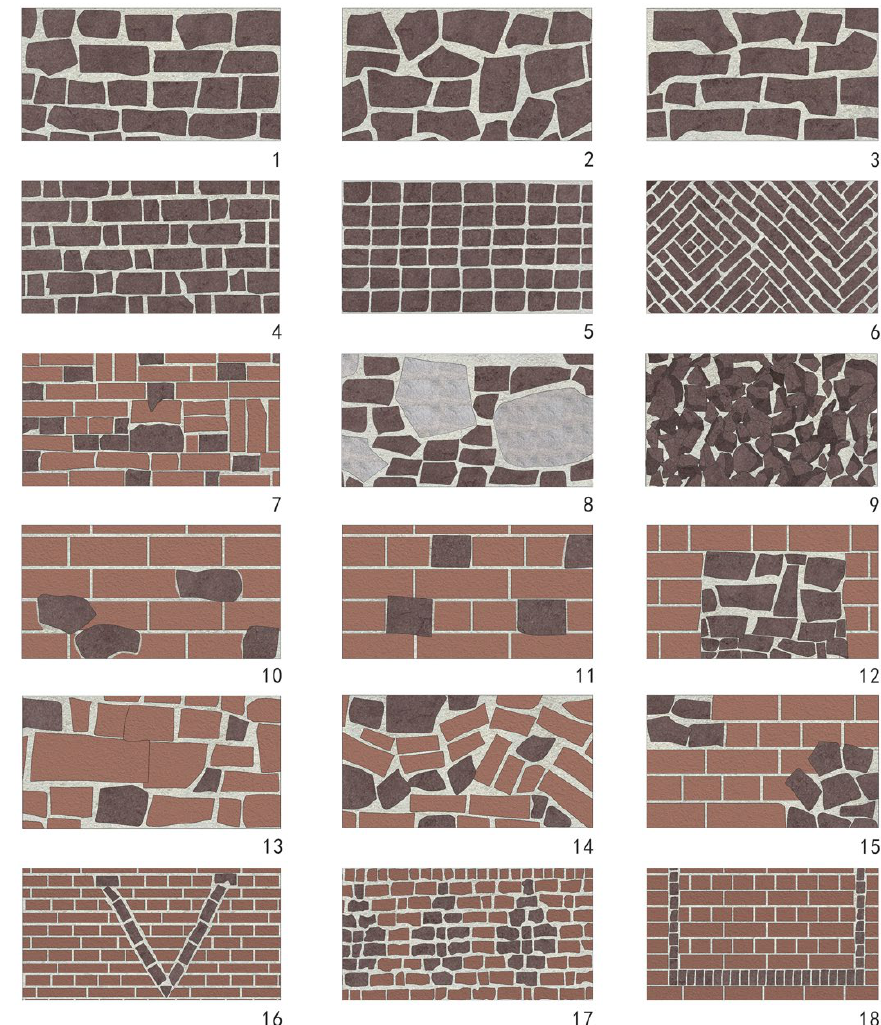
Figure 1. Diversity of clinker brickwork patterns and morphological clinker brick types based on